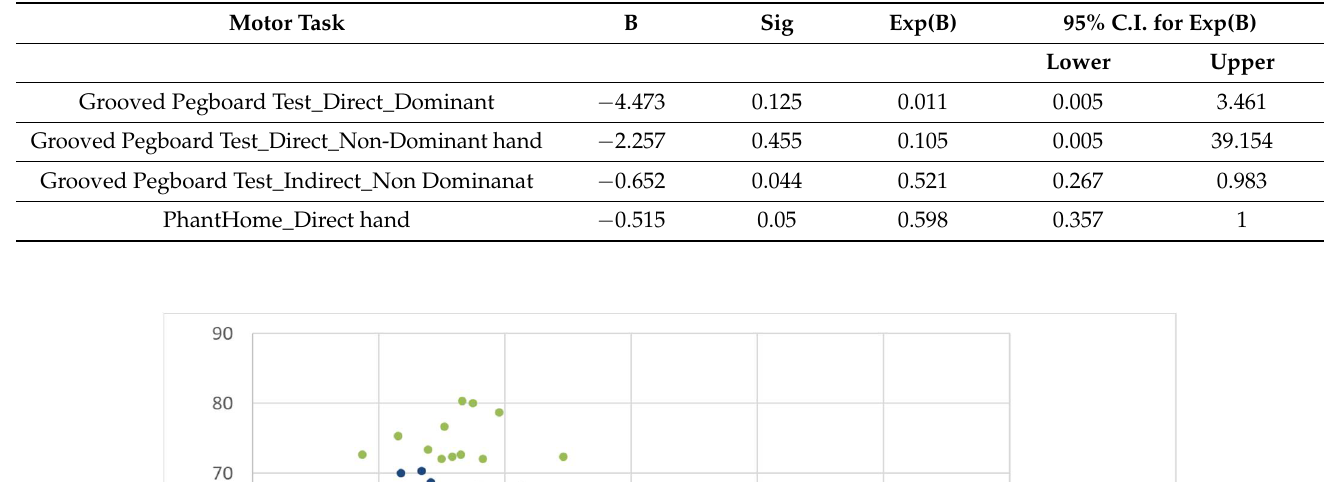
Table 4. Logistic regression analysis for explanatory variables to predict the final grade in the prosthodontic course using the Enter method.